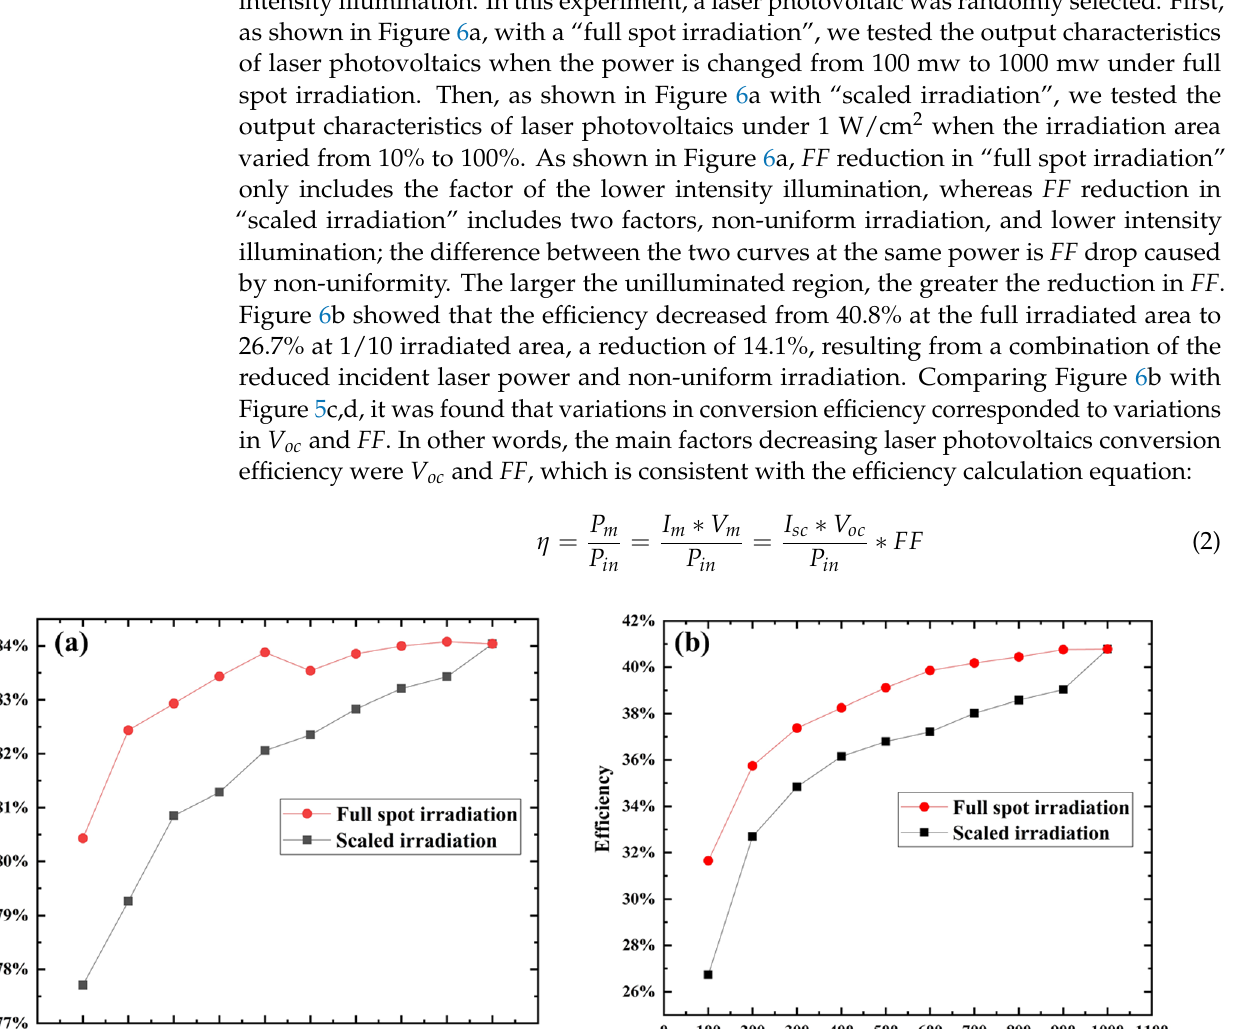
Figure 6. A comparison of the output characteristics of laser photovoltaics under different irradiation methods; ( a ) Fill factor; ( b ) Efficiency.